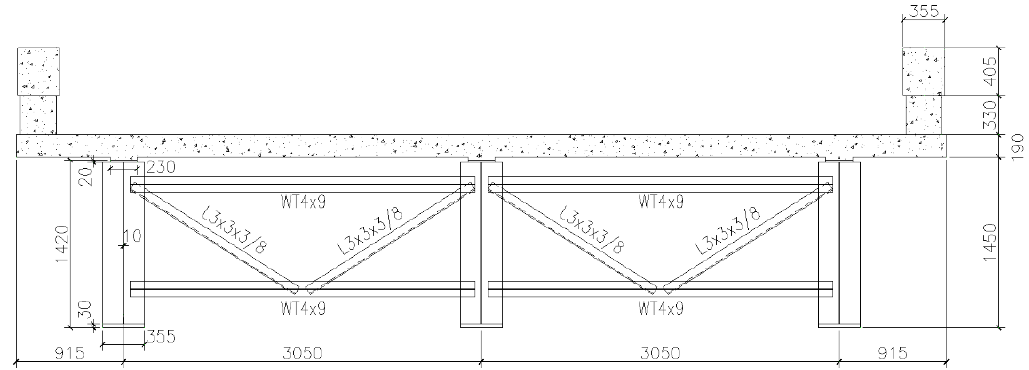
Figure 1. University of Nebraska–Lincoln I-Girder Bridge (Dimensions are in mm).